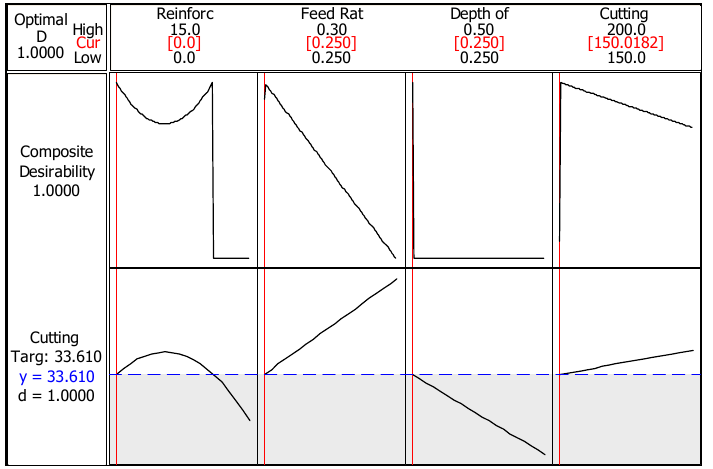
Figure 10. RSM optimization of cutting temperature.